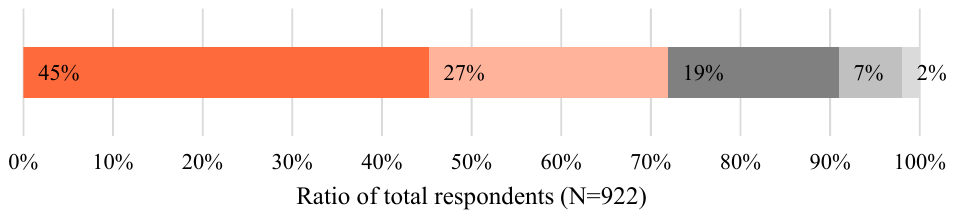
Figure 3. Experience with smart grid concept.